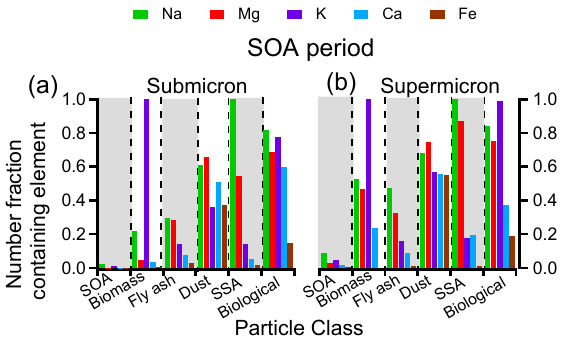
Figure 7. Size-resolved particle class compositions indicate the number fraction of particles in each class containing nonvolatile cations Na, Mg, and Fe during the SOA period in the (a) submi- cron and (b) supermicron size